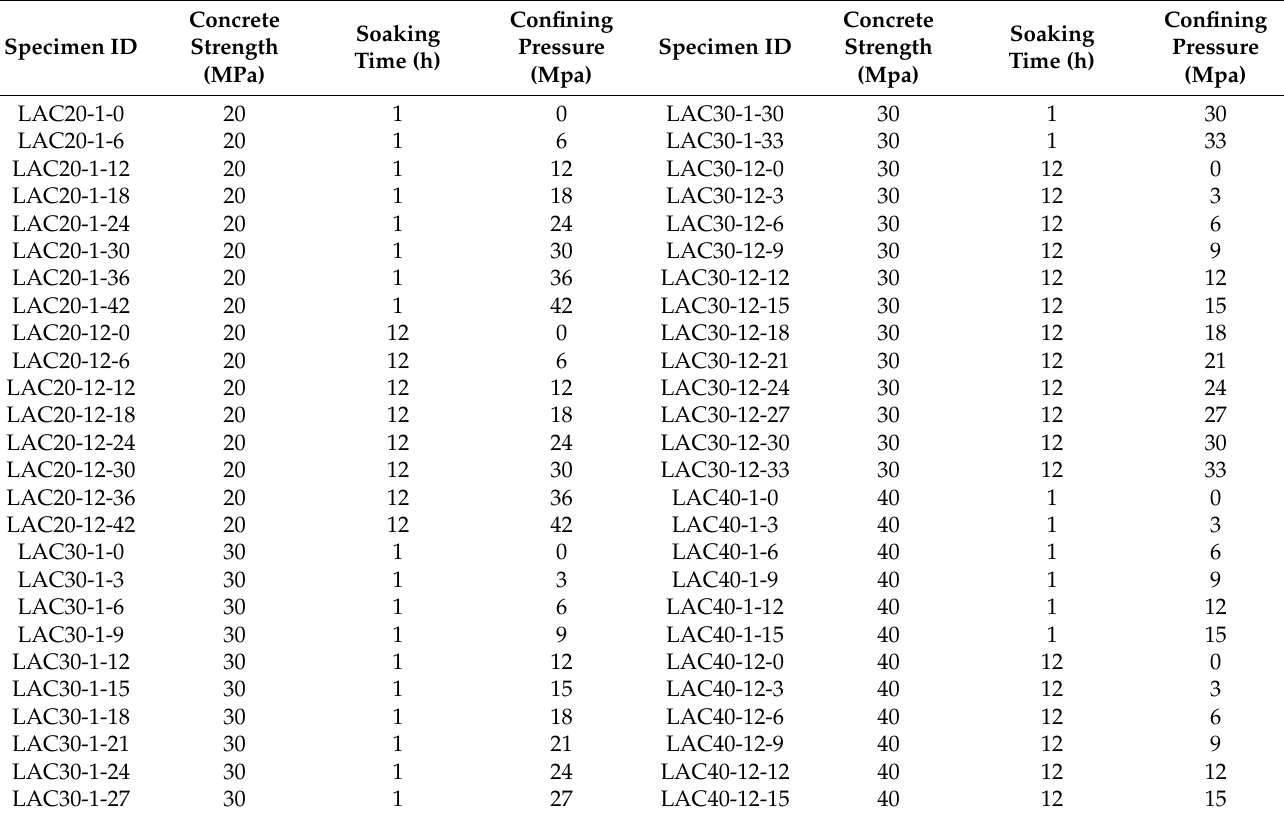
Table 3. Parameters of